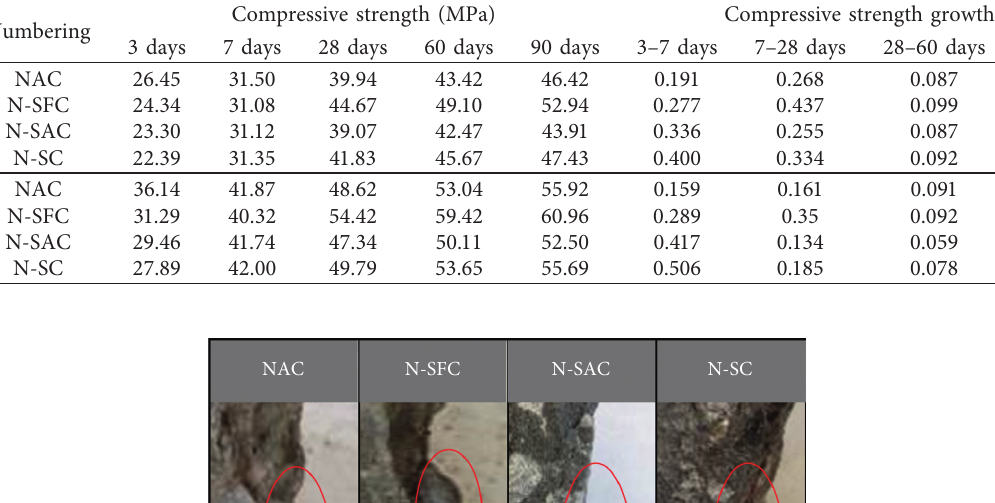
Table 5: Compressive strength of concrete after conversion.